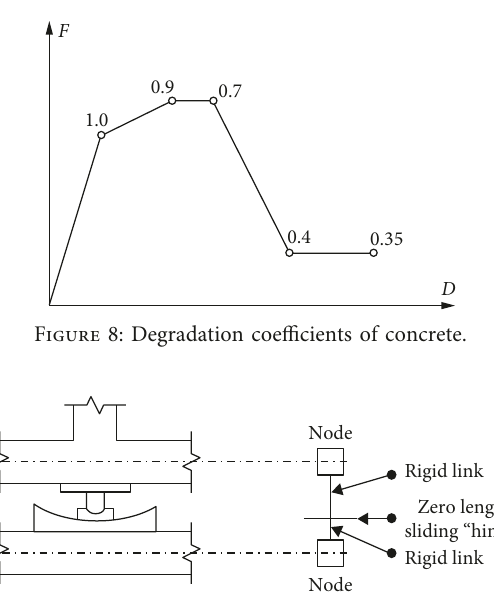
Figure 5: Plan layout of the FPB and viscous damper on the top of towers.